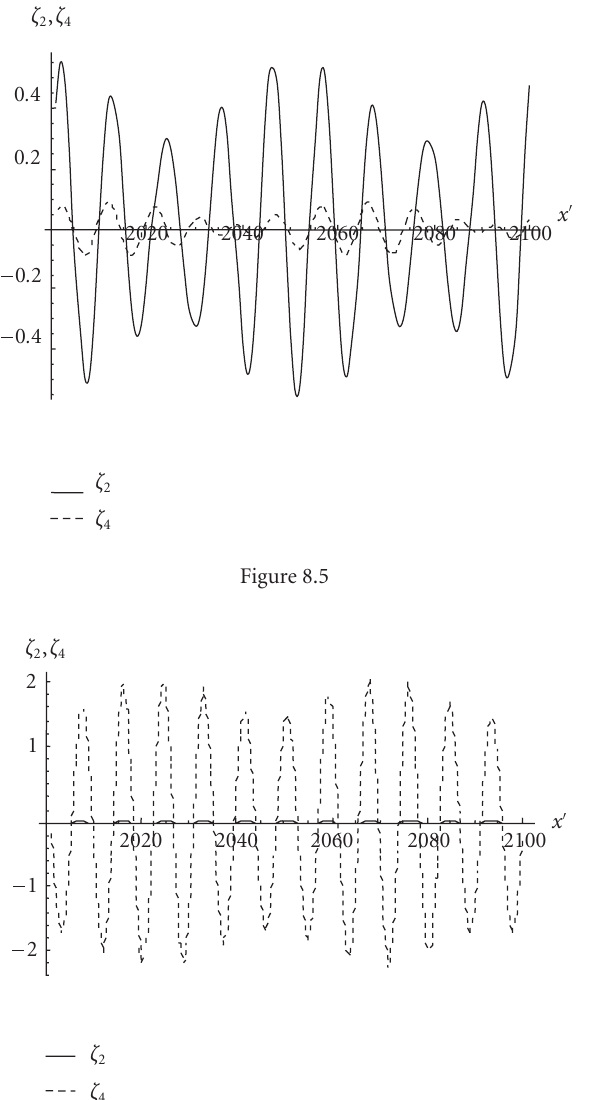
Figure 8.6. When the depth is ten times, and as a result we have taken ω (cid:6) = 6 . 3 10, ν (cid:6) = (1 / 10 3 / 2 ) × 0 .